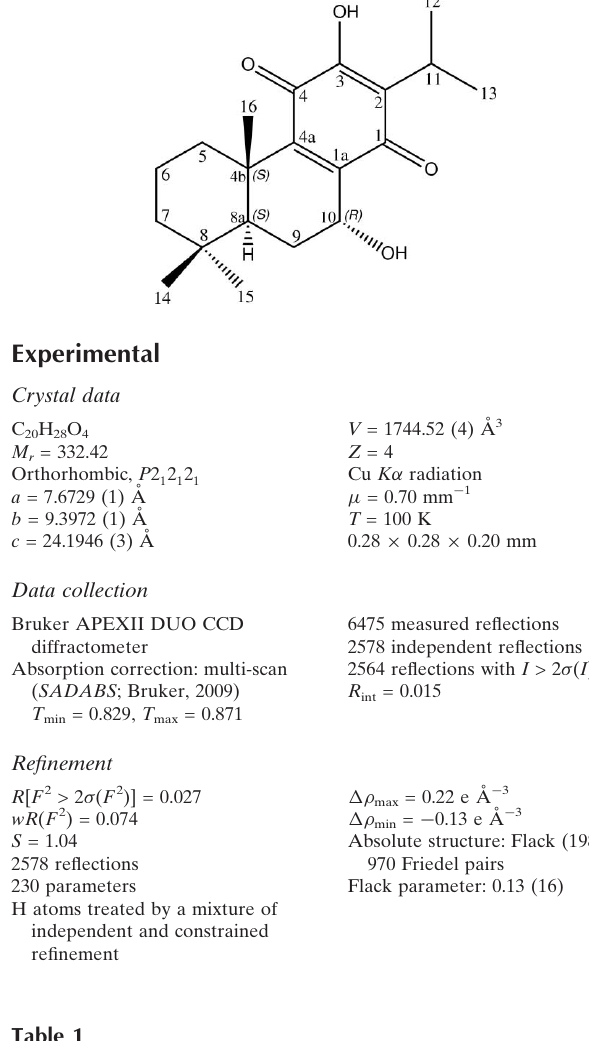
Hydrogen-bond geometry (A˚ , (cid:5)